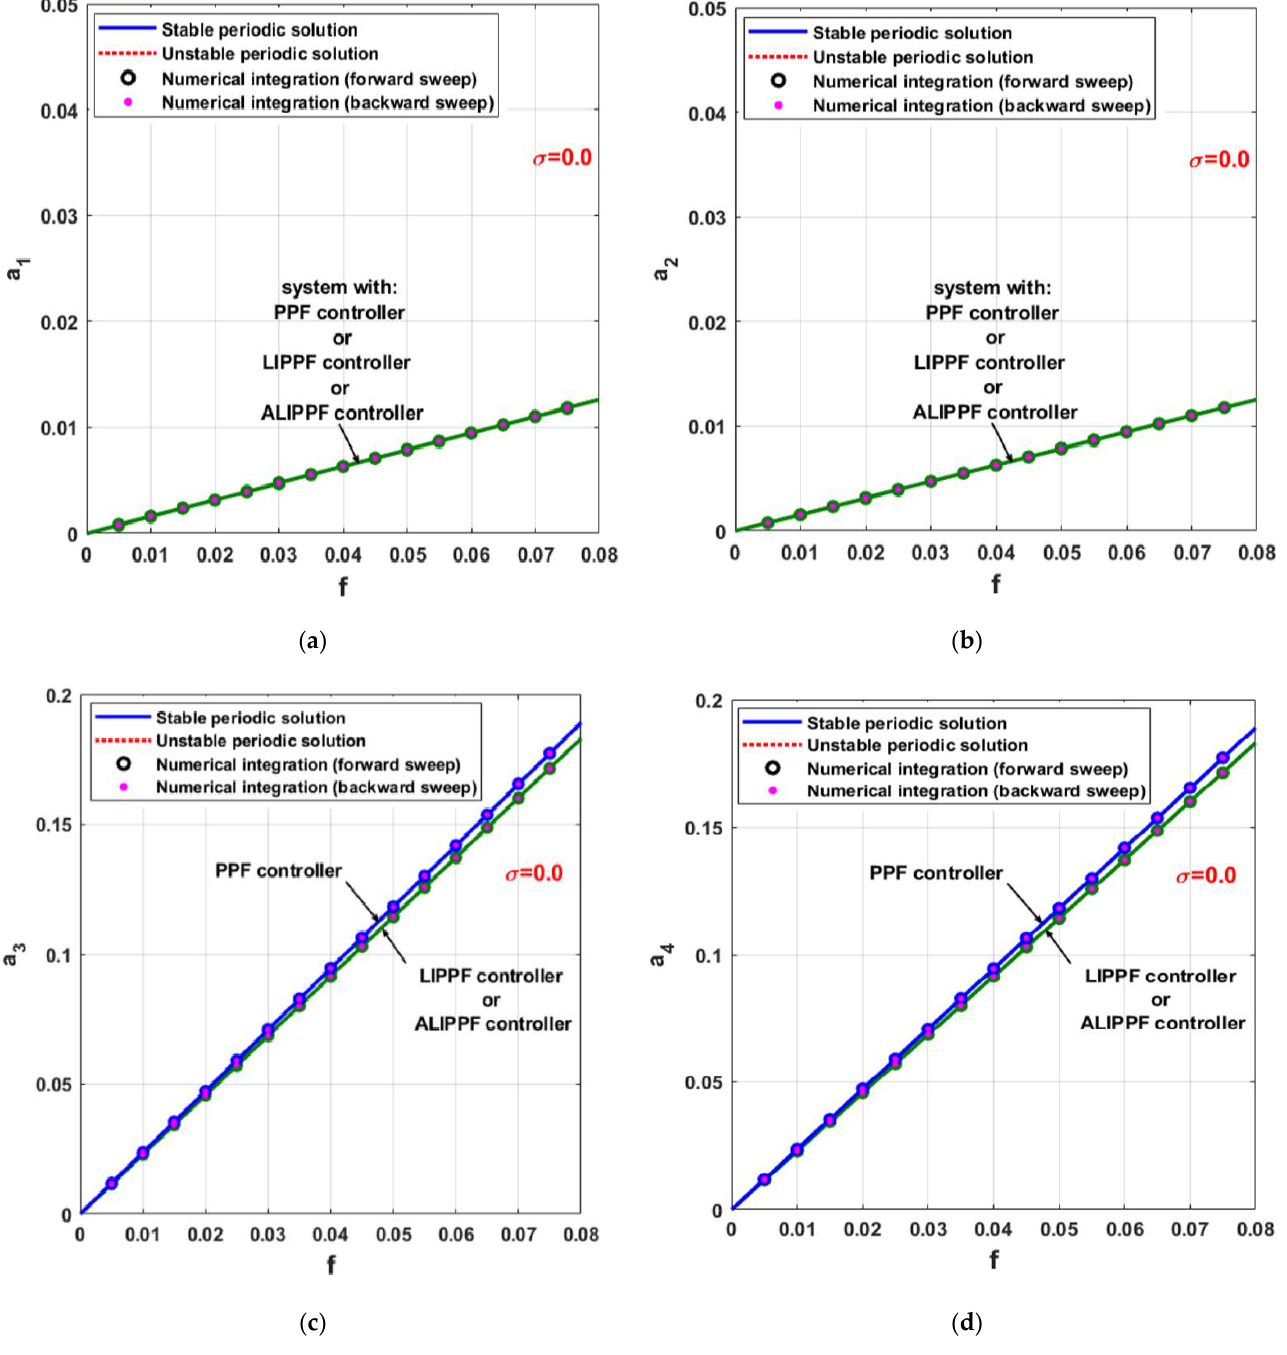
Figure 11. Vibration amplitudes of the rotor system, PPF-controller, LIPPF-controller, and ALIPPF- controller using the rotor eccentricity 𝑓 a bifurcation parameter when 𝜎 = 0 : ( a ) vibration amplitude in 𝑋 1 direction, ( b ) vibration amplitude in 𝑋 2 direction, and ( c , d ) vibration amplitudes of the PPF-controller, LIPPF-controller, and ALIPPF-controller.